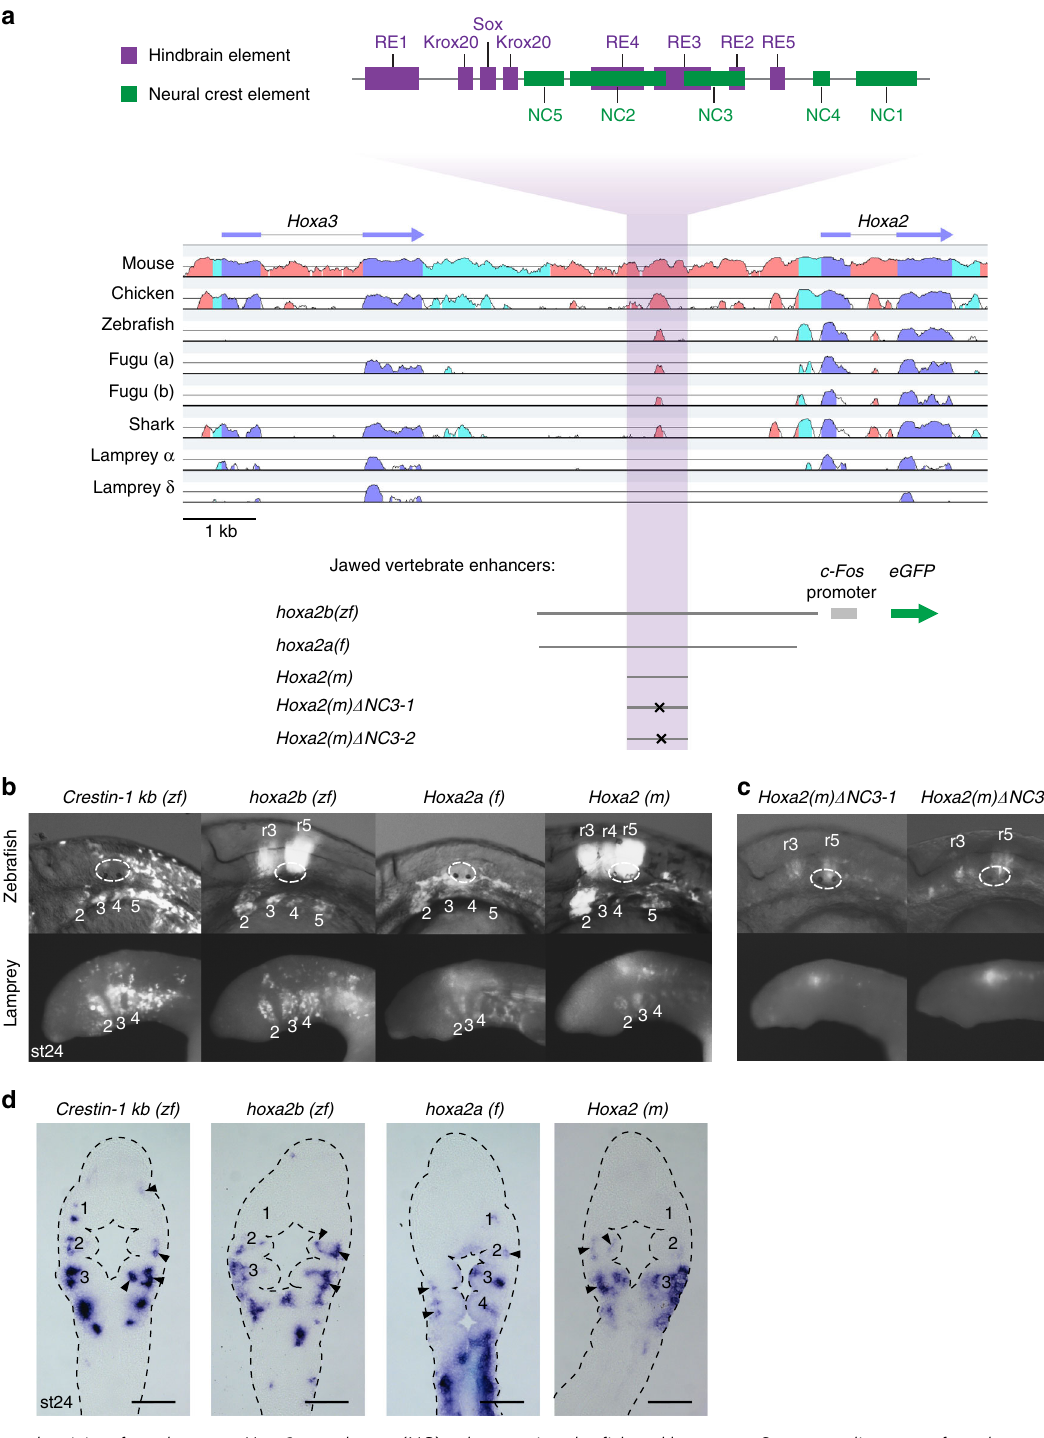
Fig. 3 Conserved activity of gnathostome Hoxa2 neural crest (NC) enhancers in zebra fi sh and lamprey. a Sequence alignment of gnathostome Hoxa2-Hoxa3 and lamprey hox2-hox3 gene loci against the human locus. Conserved non-coding sequences (pink), untranslated regions (UTRs) (cyan) and coding sequences (blue) are highlighted. The relative locations of the mouse hindbrain and NC cis -elements (top) are shown. Gnathostome Hoxa2 enhancers used for cross-species reporter analysis are detailed below the alignment. Letters within parenthesis indicate species of origin of the enhancer: zf, zebra fi sh; f, fugu; m, mouse. b , c Green fl uorescent protein (GFP) reporter expression in zebra fi sh and lamprey embryos (lateral views), mediated by wild-type ( b )